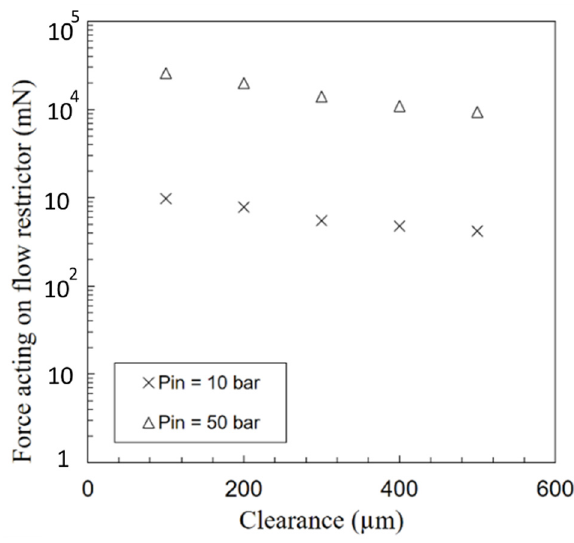
Figure 3. Obtained experimental results of exerted forces for the needle draft angle of 15° at upstream pressures of 10 and 50 bar.